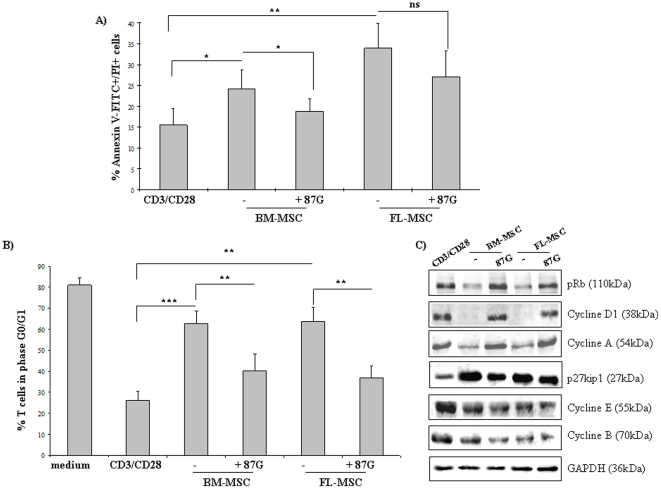
MSC regulates cell cycle entry of T cells, but do not induce cell apoptosis.Activated T cells were cultured with MSC (ratio T∶MSC of 5∶1) for 4 days. (a) Activated T cells were cultured with fetal and adult MSC to evaluate their apoptosis activities using the Annexin-V/PI assay. (b) Distribution of the G0–G1 phase in activated lymphocytes, as assessed by flow cytometry. (c) Expression of p27Kip1, pRb, and cyclins A, E, B and D1 were evaluated by western blot analysis. GAPDH was used as a loading control. Averages of four independent experiments are shown. Error bars represent SD. P-values were calculated using Student's t-test. *P<0.05, **P<0.01; ***P<0.001, ns = not statistically significant.